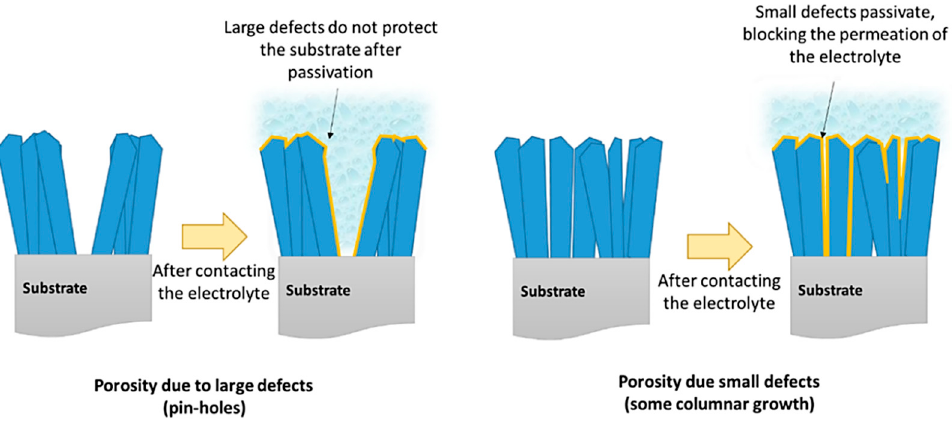
Figure 5. Passivation of pores and defects.